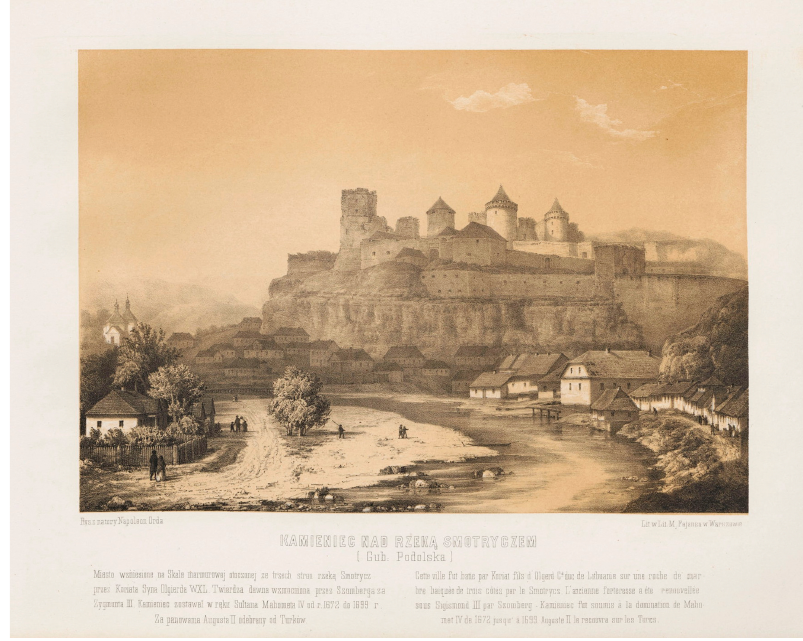
Figure 38. Napoleon Orda. Kamieniec Podolski. Zamiek ,